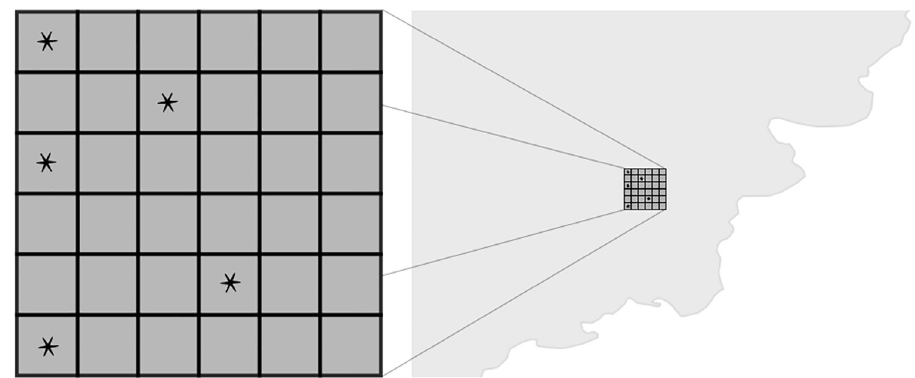
Fig 4. Event representation in SCEG. At the smallest level, the SCEG simulator represents a lattice of simulated locations orders of magnitude smaller than the areal units used for statistical analysis. In one time-step of the simulation, all simulated locations inside the country potentially generate a conflict event associated with their